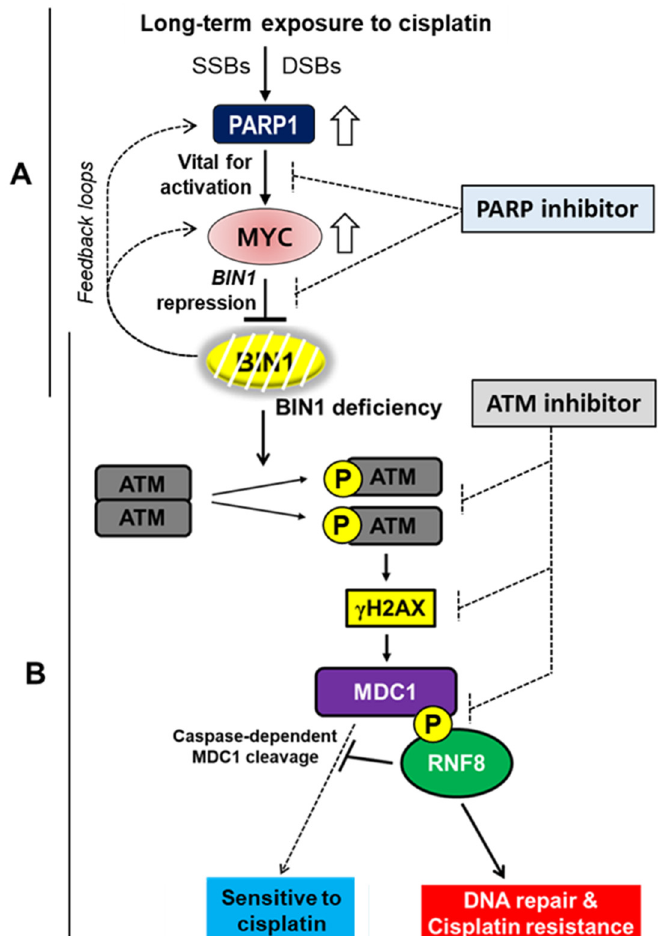
Figure 7. New synthetic lethal signaling cascades by co-using PARP and ATM inhibitors to eradicate the resistance to cisplatin. ( A ) During DNA replication, platinum-DNA adducts increase SSBs and DSBs, which automatically activate PARP1, one of the most immediate-early nuclear enzymes responsible for maintaining genome stability [19,45]. Subsequently, activated PARP1 assists MYC to repress BIN1 promoter activity (this study). Because reduced BIN1 automatically activates endogenous PARP1 [19] and MYC activities [9,10,13], BIN1 deficiency forms unique feedback loops to infinitely repress the BIN1 promoter activity by activating PARP1 and MYC. Instead of directly targeting neoplastic MYC transcription factor, a PARP inhibitor, which is currently approved for clinical study for human cancers in combination with ‘BRCAness,’ could be an alternative strategy to attenuate deregulated MYC activity in spontaneously cisplatin-resistant cancer cells; ( B ) by physically releasing the E2F1 nuclear protein [21] (omitted here), a BIN1 loss facilitates ATM auto-phosphorylation, thereby promoting γ H2AX formation and following ATM-dependent MDC1 phosphorylation [21,28]. Accordingly, RNF8 physically binds to ATM-phosphorylated MDC1, thus prohibiting caspase-3- induced proteolytic cleavage of MDC1 [29]. We propose that the ATM-dependent formation of the MDC1-RNF8 complex serves as a watershed to interfere with cisplatin sensitivity, thereby facilitating DSB repair and subsequent cisplatin